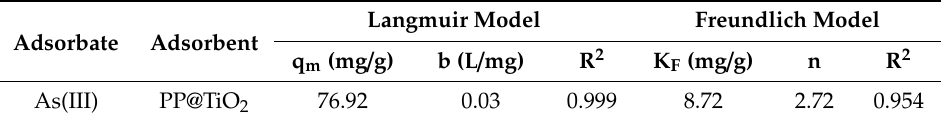
Table 1. Langmuir and Freundlich isotherm parameters for the adsorption of As(III) onto PP@TiO 2 . Adsorbate